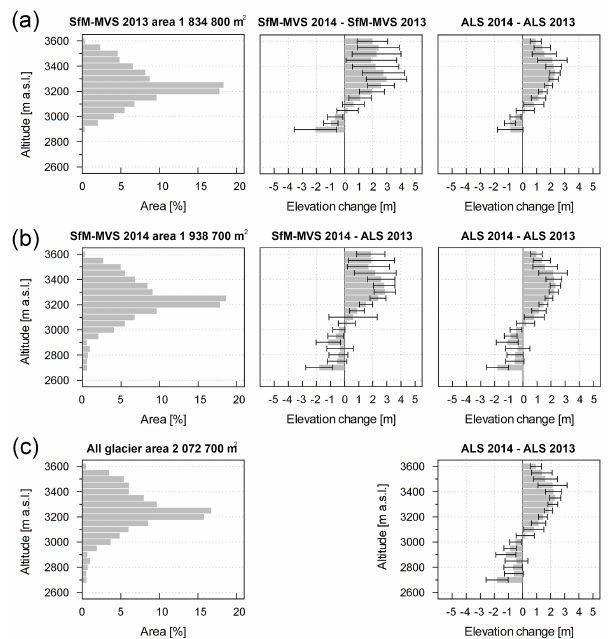
Figure 18. Area–altitude distribution and surface elevation change with standard deviation for the glaciological year 2014/2013 dis- played for altitudinal bands with 50m interval. The elevation changes were calculated between (a) SfM–MVS DEMs of 2013 and 2014 in the 2013 photogrammetric reconstructed area; (b) SfM– MVS DEMs of 2014 and ALS DEM of 2014 in the 2014 pho- togrammetric reconstructed area; (c) ALS DEMs of 2013 and 2014 of the entire glacier. The photogrammetric results were compared with the corresponding ALS results calculated in the same